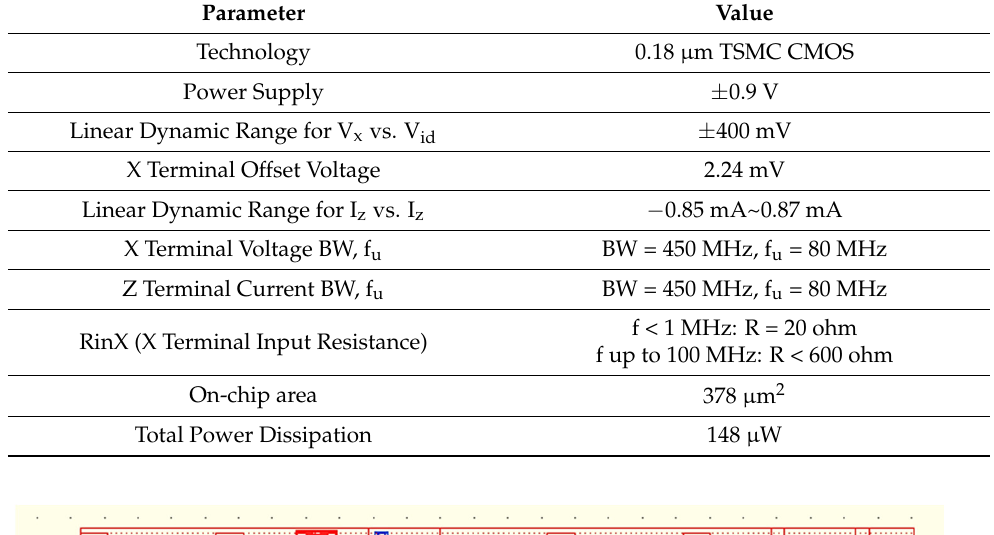
Figure 5. The X terminal input resistance R X versus frequency changes. It is measured less than 20 ohm in low frequency and DC operation regions. Table 2. Simulation results of designed DVCCII. Table 2. Simulation results of designed DVCCII.